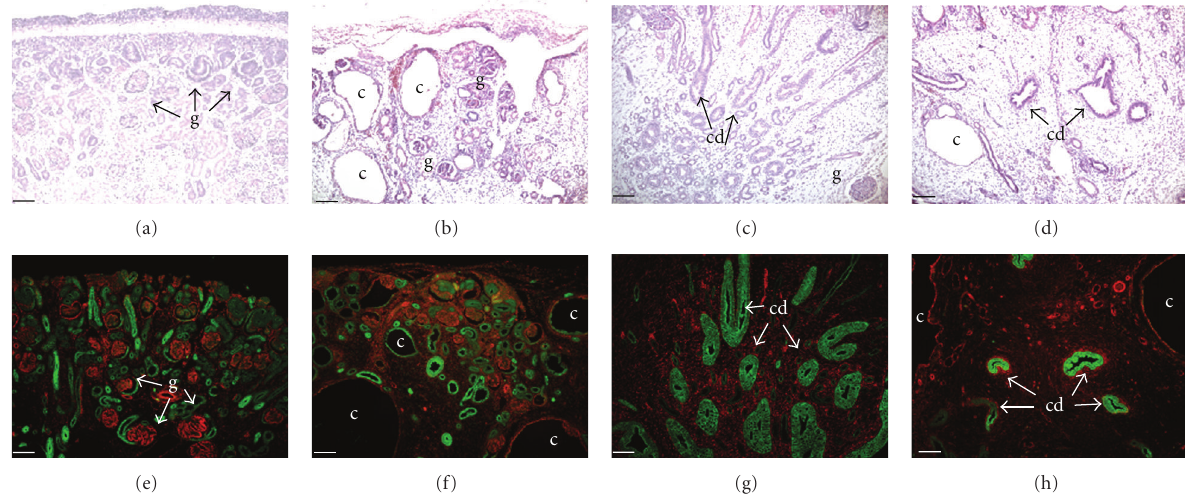
Figure 2: Histological features of human fetal obstructive nephropathy . Obstructed 18 weeks gestation kidney shows disorganized cortical architecture with multiple glomerular cysts (c), decreased glomerular (g) endowment ((b) and (f)), and reduced number and dilation of the collecting ducts (cd) in the hypoplastic medulla ((d) and (h)). Cortex ((a) and (e)) and medulla ((c) and (g)) of a normal 18-week gestation kidney. (a)–(d): hematoxylin and eosin stain; (e)–(h) immunofluorescence histochemistry: green = cytokeratin, red = vimentin. Scale bar = 100 μ